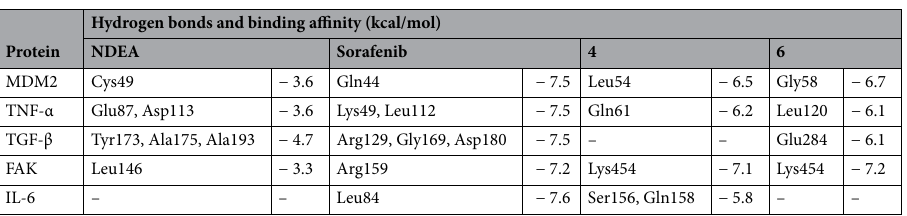
Table 1. Hydrogen bonds and binding affinities of the protein–ligand docked complexes.